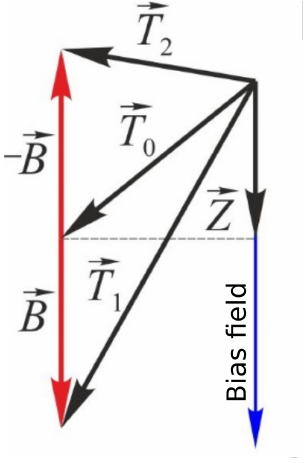
Figure 1. Assembly of the POS-4 magnetometer (from left to right: a solenoid with a coil system and a sensor, an electronics unit with a battery, an interface switching unit and a recording laptop).